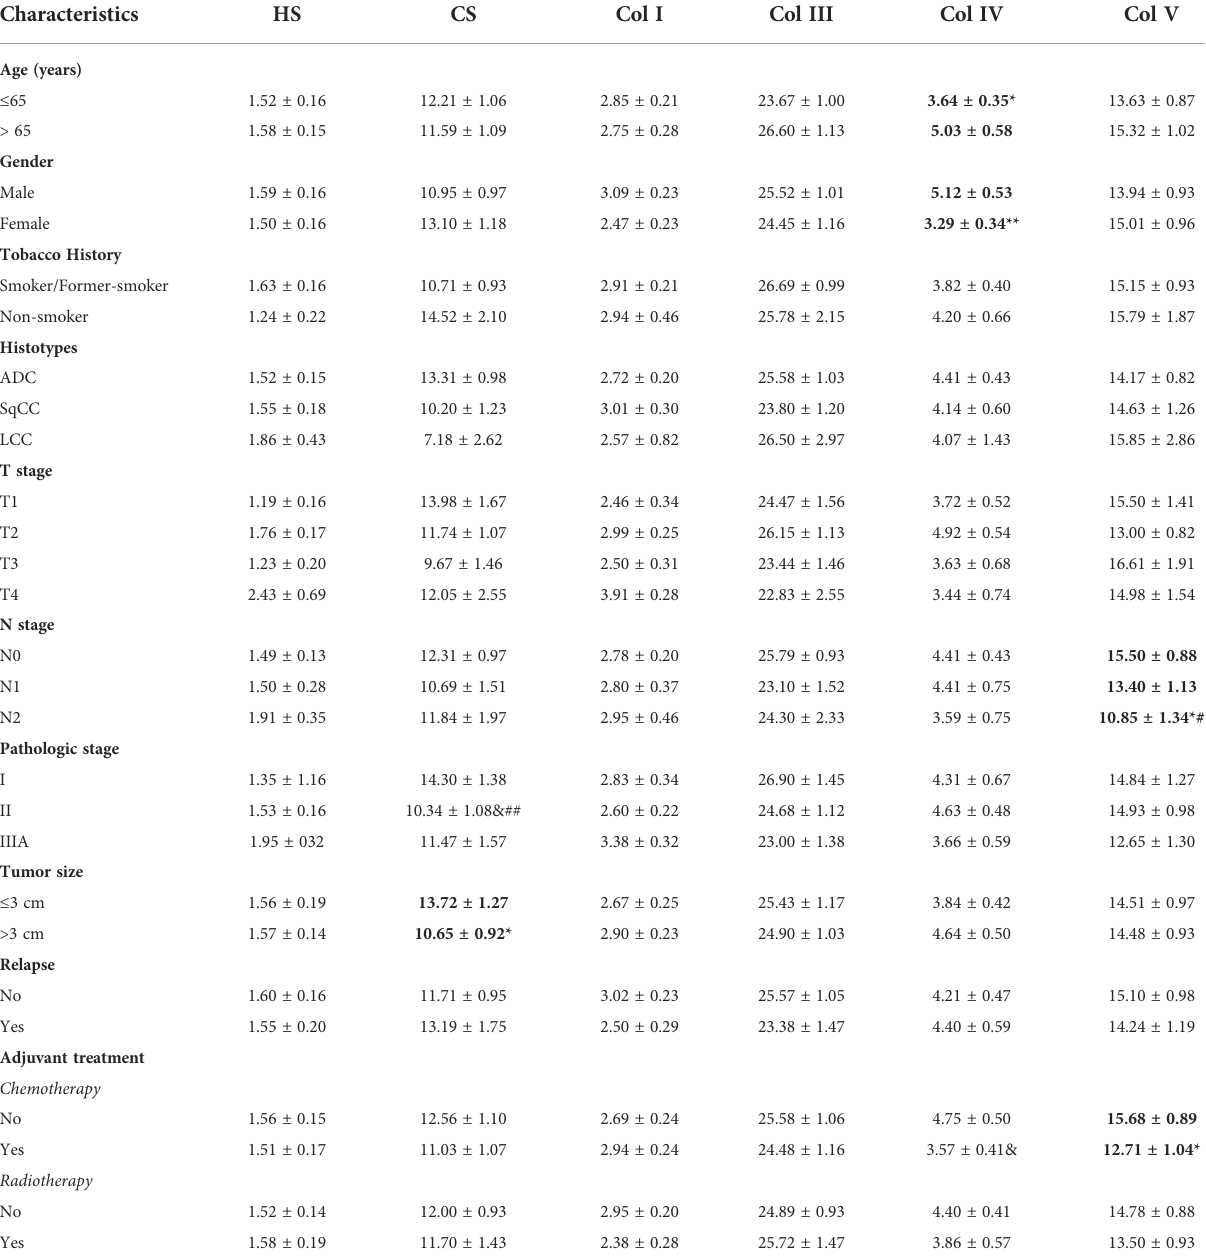
TABLE 3 Association between clinicopathologic characteristics and mean expression (% positive expression) of GAGs and collagen types ( t test and ANOVA, P<0.05).